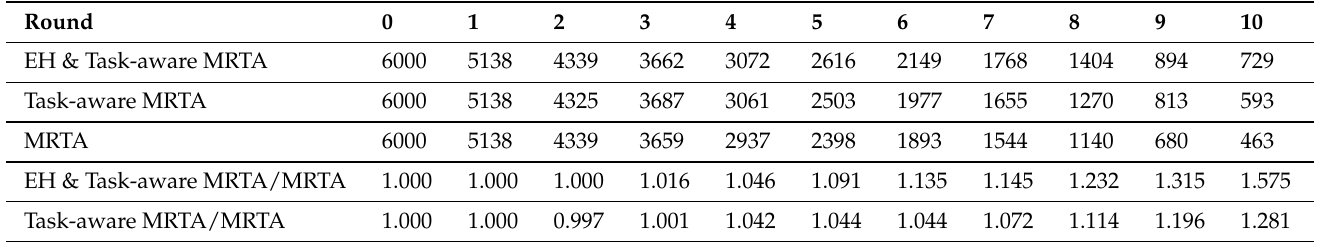
Table 5. Total remaining energy in the batteries of the 10 robot nodes which are located initially as given in Figure 8 versus the number of rounds under Markov EH